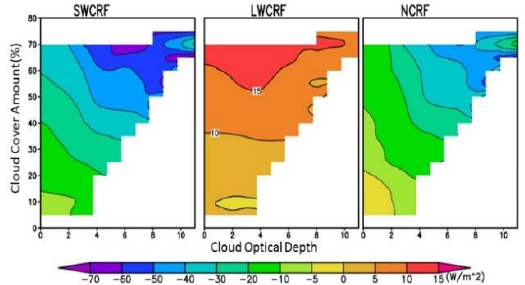
Figure 11. Variation of SWCRF, LWCRF and NCRF (Wm - 2 ) at diffent COD and total cloud cover (%)